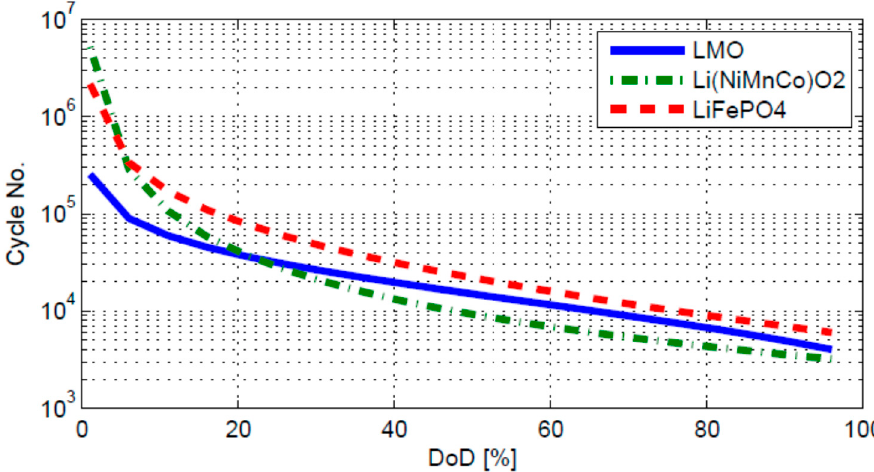
Figure 3. E ff ects of DoD to a few types of lithium battery Figure 3. Effects of DoD to a few types of lithium battery [23]. Figure 3. Effects of DoD to a few types of lithium battery [23].